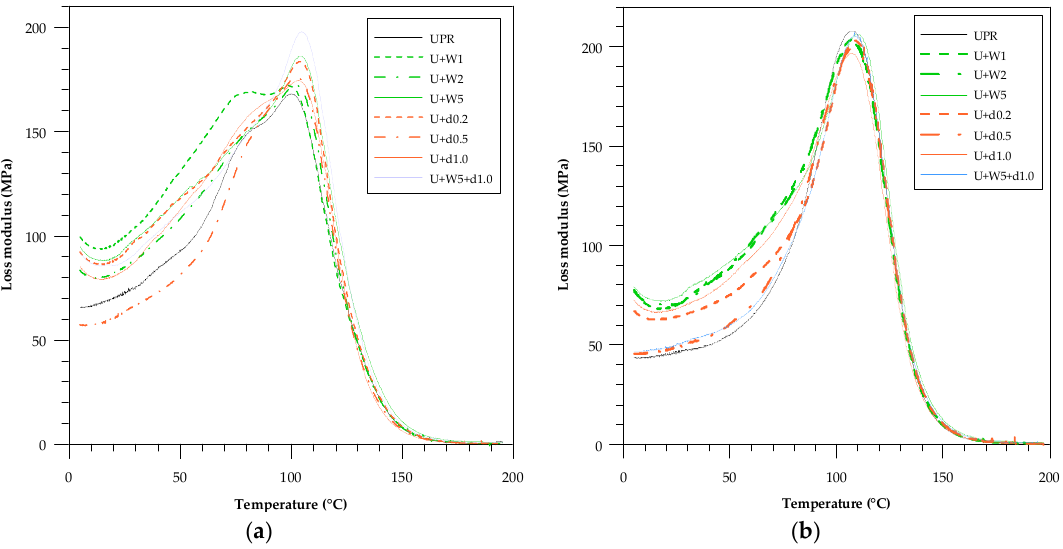
Figure 4. Loss modulus (E”) vs. temperature for pure UPR and green composites with wood flour (WF) and dba. ( a ) Before the accelerated aging test and ( b ) after the accelerated aging test.